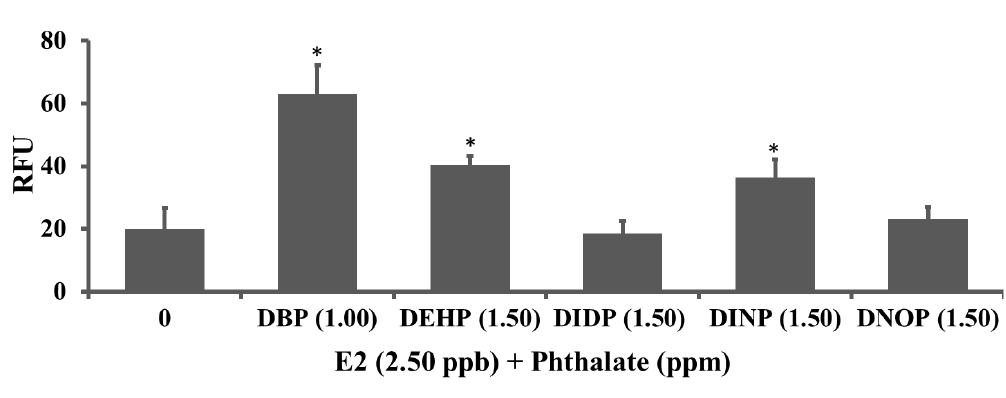
Figure 5. Enhanced-estrogenic activity of phthalates. DBP (1.00 ppm), DEHP (1.50 ppm) and DINP (1.50 ppm) significantly increased, and DIDP (1.5 ppm) and DNOP (1.5